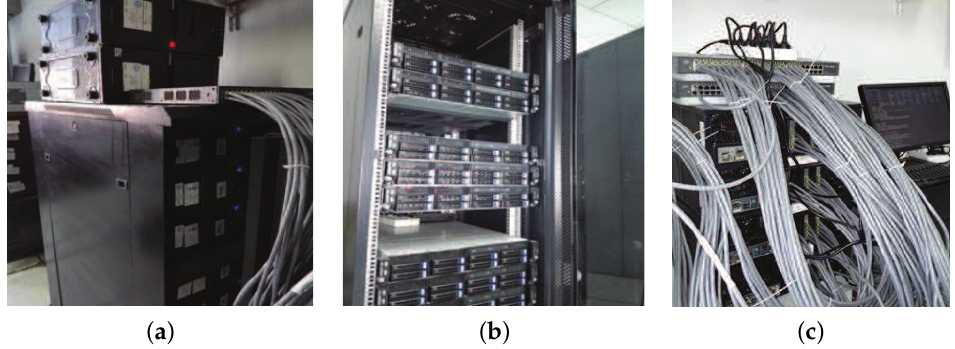
Figure 6. Grouping of server cluster. ( a ) Sending server cluster; ( b ) Storing server cluster; ( c ) Access server